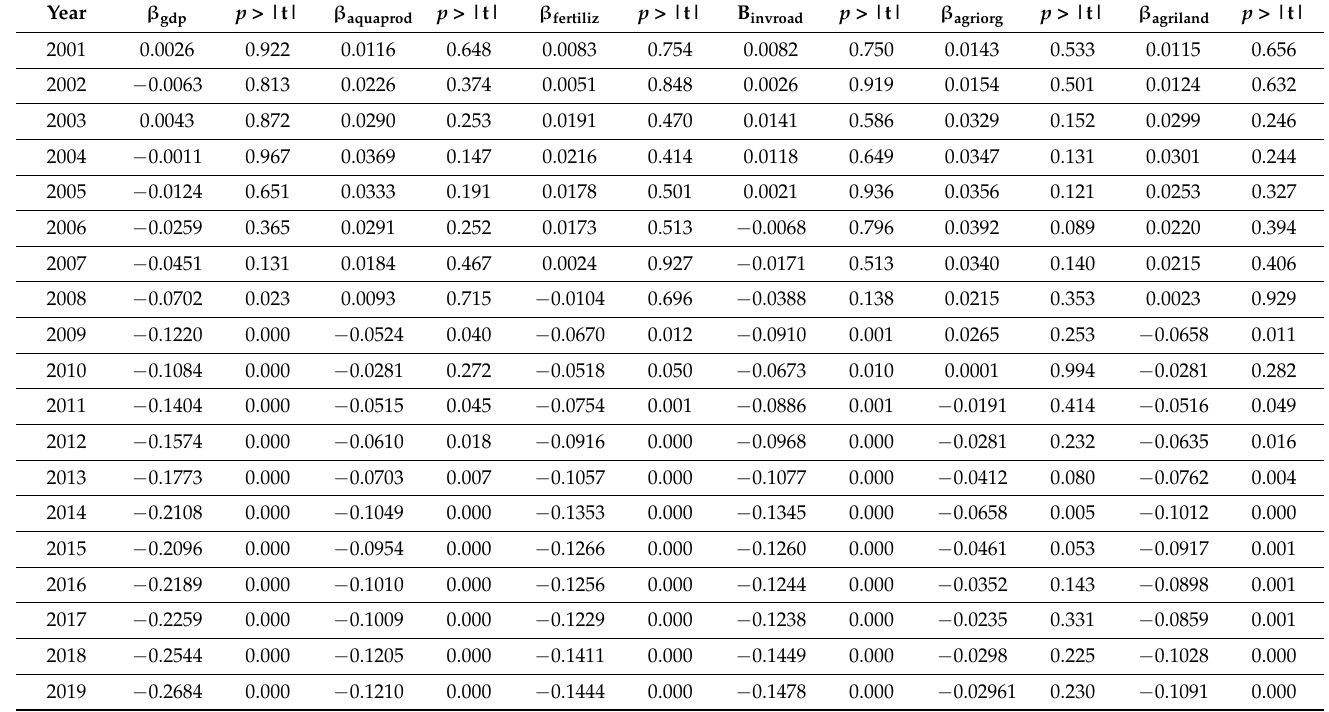
Table 3. The variable’s influence on the pollution reduction in temporary dynamics by